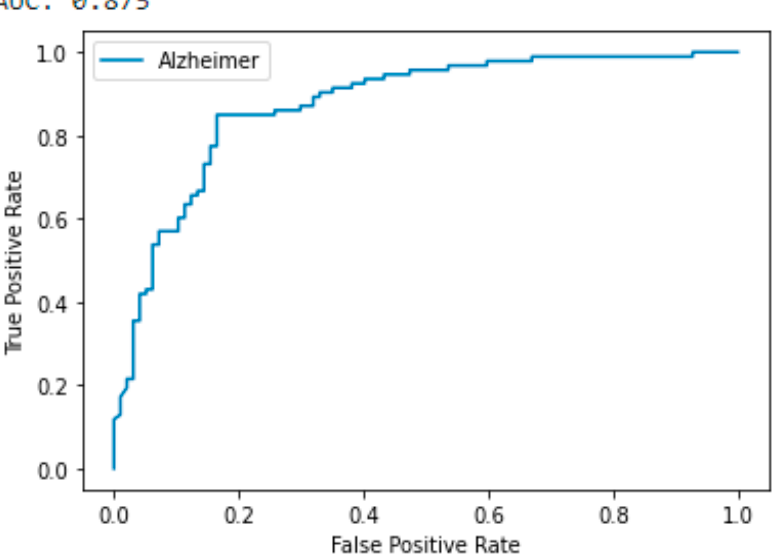
Figure 5. ROC curve and AUC for AD vs. CTL classification. The pairwise comparison of AD and CTL classes resulted in a 0.875 AUC. The Y-axis represents the true positive rate, and the X-axis represents the false positive rate.